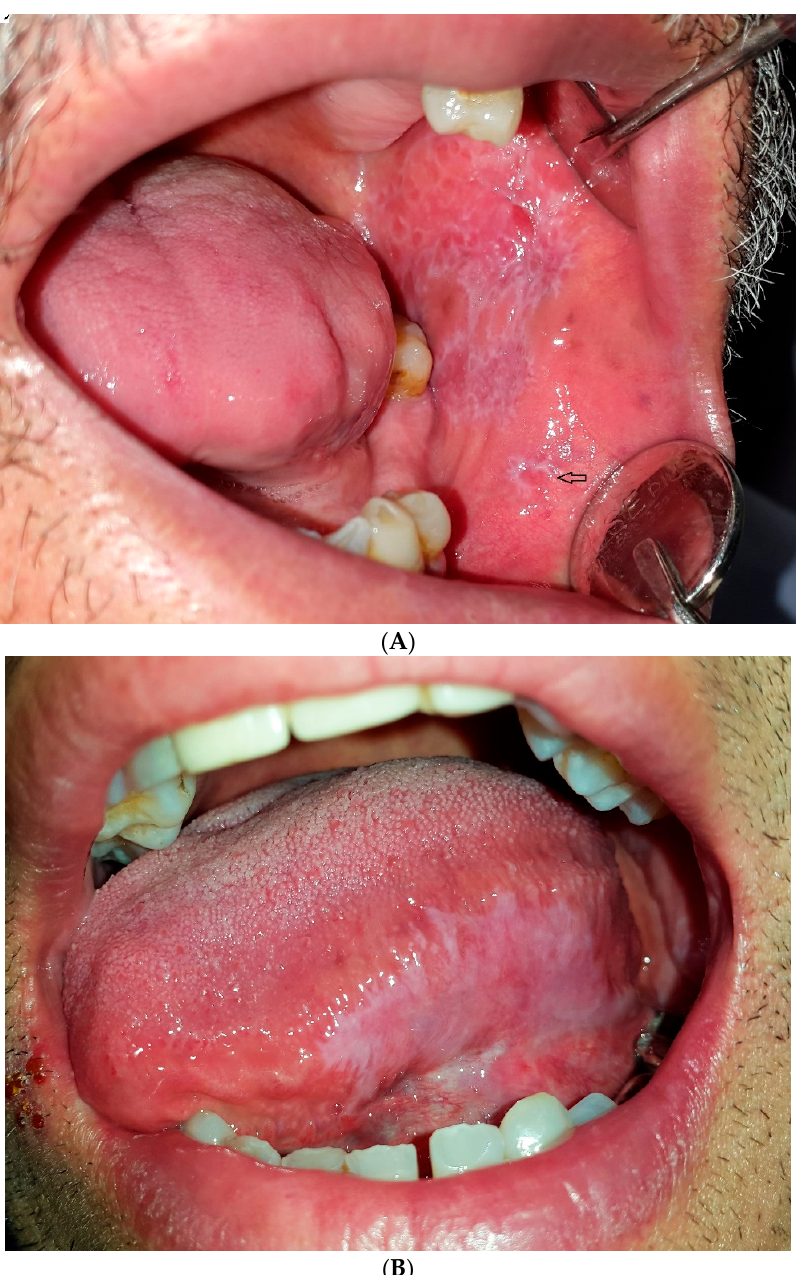
Figure 6. Clinical features of oral lichen planus with specific white pattern, ( A ) reticular OLP; the arrow shows annular form; ( B ) plaque-like OLP.